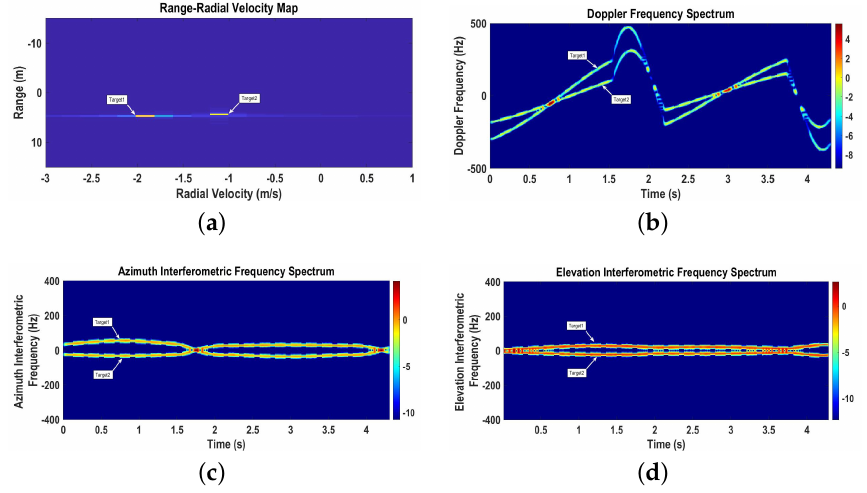
Figure 9. Range–radial velocity map, time-varying Doppler, and azimuth interferometric and el- evation interferometric spectrograms for Scenario 2. ( a ) Range–radial velocity map; ( b ) Doppler spectrogram; ( c ) Azimuth interferometric spectrogram; ( d ) Elevation interferometric